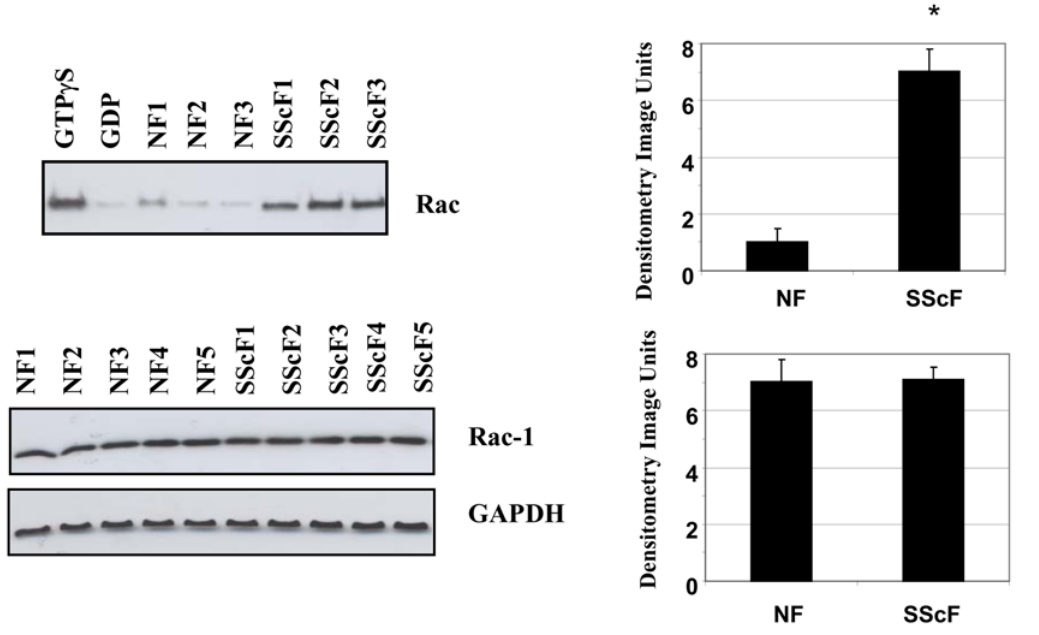
Figure 1. Rac activity is elevated in dermal fibroblasts cultured from scars of SSc patients. Cells were loaded with or without GTP c S (positive control, to assess maximal Rac activation) or GDP (as a negative control). Rac-GTP was immunoprecipitated from cell lysates. The precipitated Rac-GTP was detected by immunoblot analysis using anti-Rac. In parallel, whole cell lysates were subjected to SDS/PAGE and Western blot analysis with an anti-rac antibody. Quantitative densitometry data is indicated on the right. Lanes are: GTP c S, GDP, cells from three normal individuals (N1, N2, N3) and three individuals with SSc (SScF1, SScF2, SScF3). Experiments were performed on cells derived from 6 normal individuals and 6 SSc patients. Quantitative densitometry data is indicated on the right (*=p , 0.05 relative to wild-type